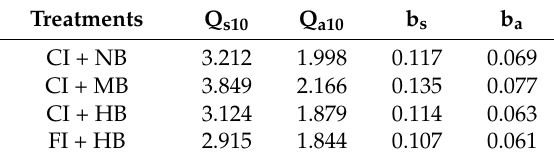
Table 5. Soil temperature sensitivity (Q s10 ) and air temperature sensitivity (Q a10 ) with different treatments.